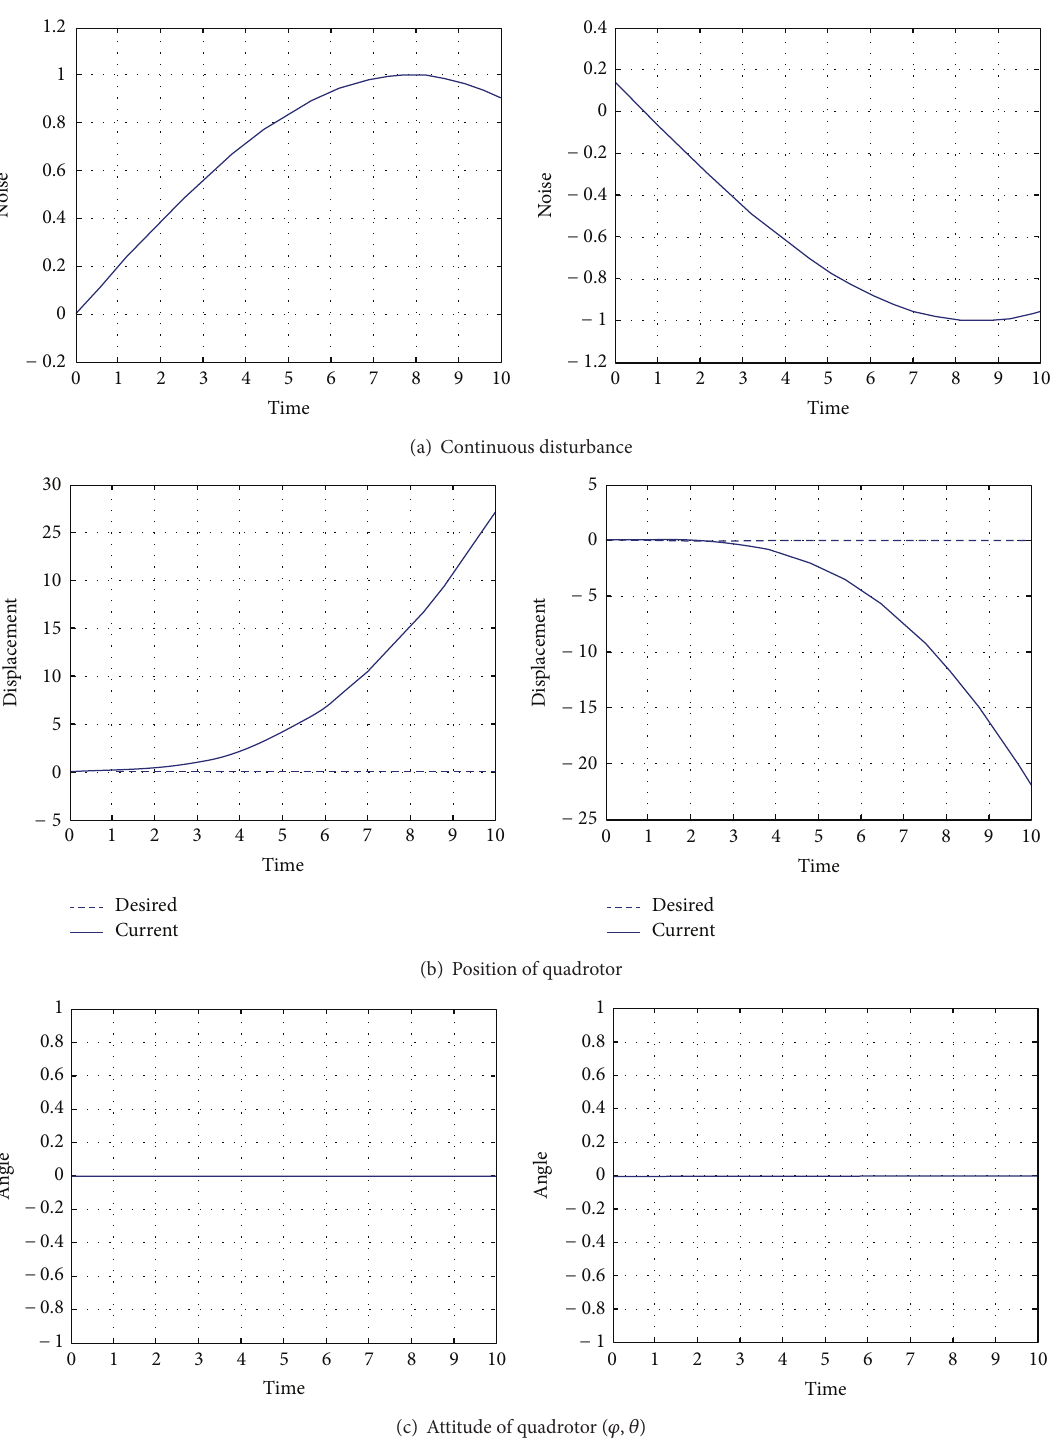
Figure 8: Results from the partially simulated system (layer 3 is